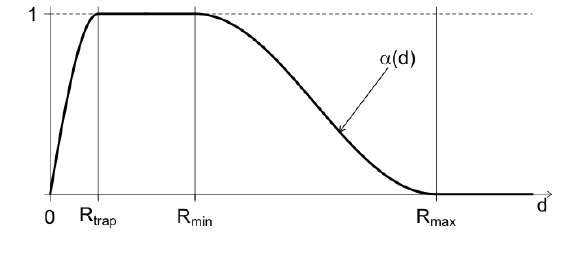
Fig. 1. Graph of the function α ( d